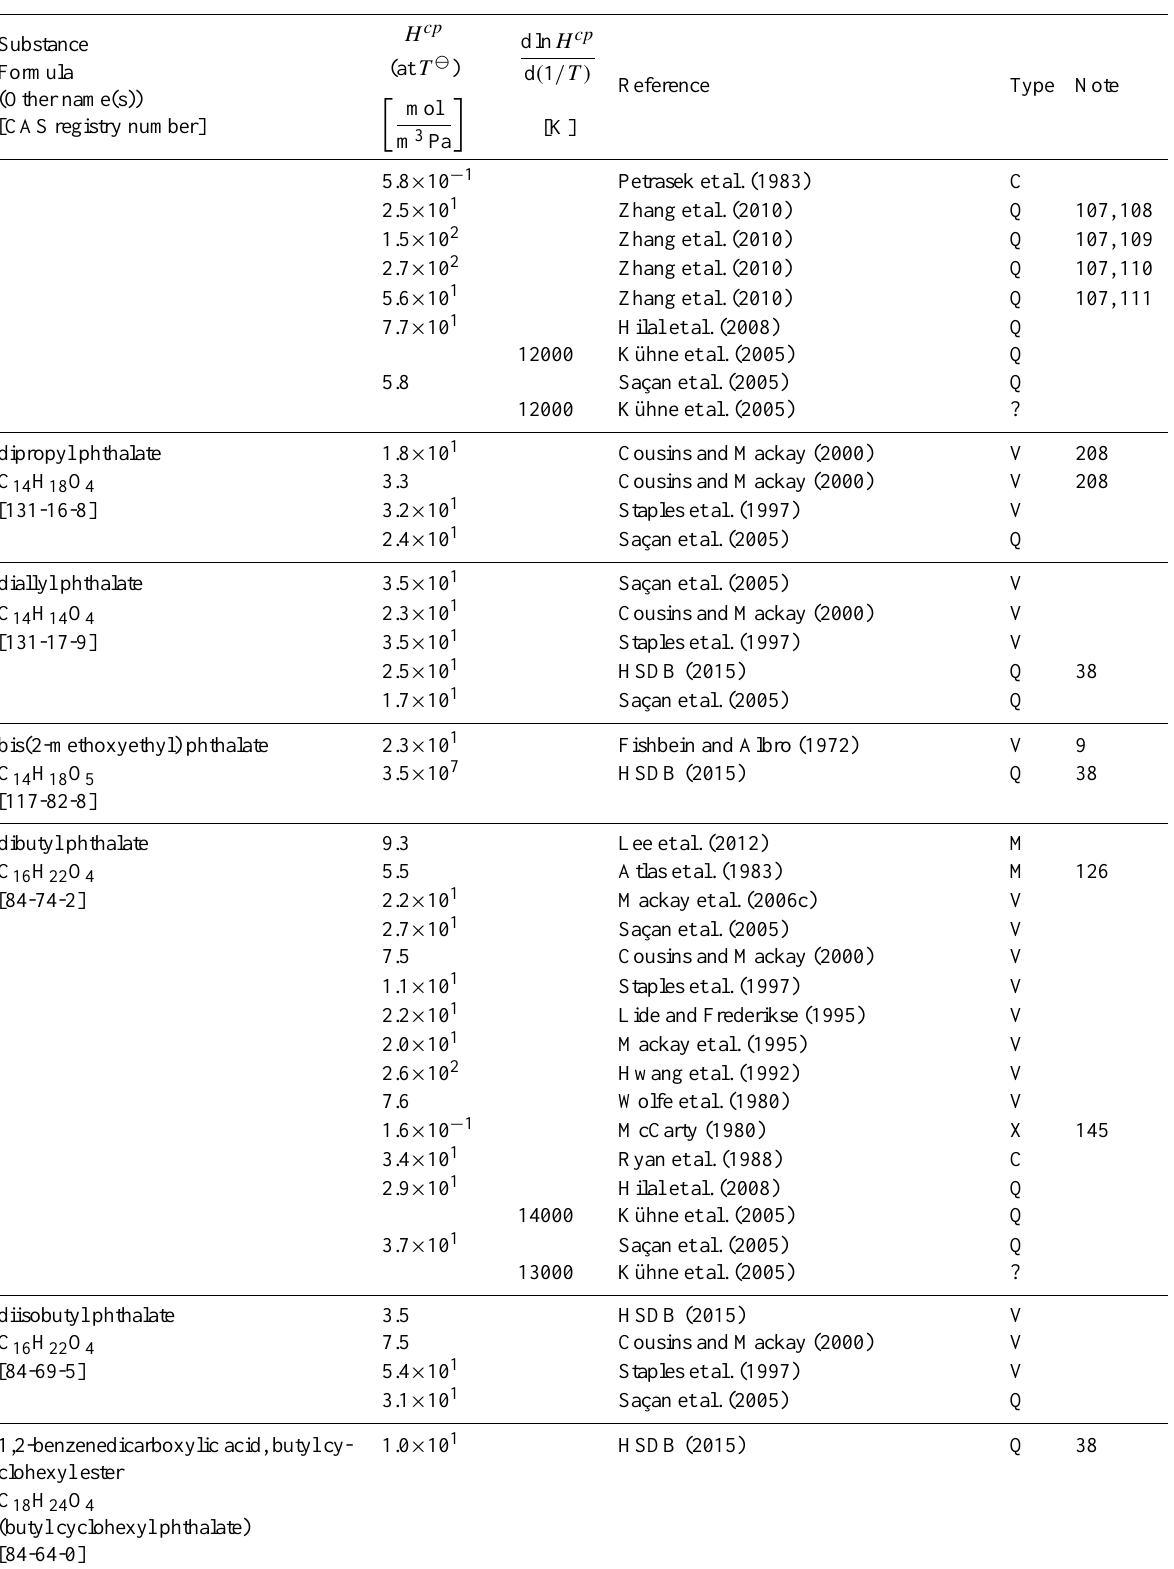
Table 6: Henry’s law constants for water as solvent